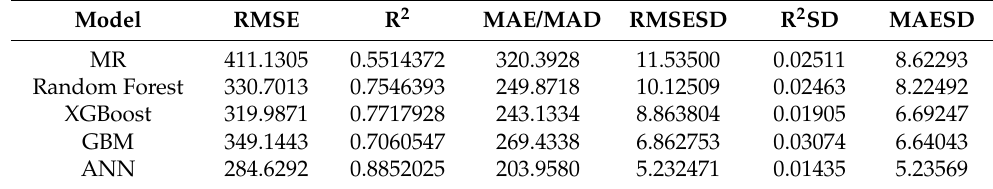
Table 2. Goodness-of-fit statistics for statistical and machine learning techniques.